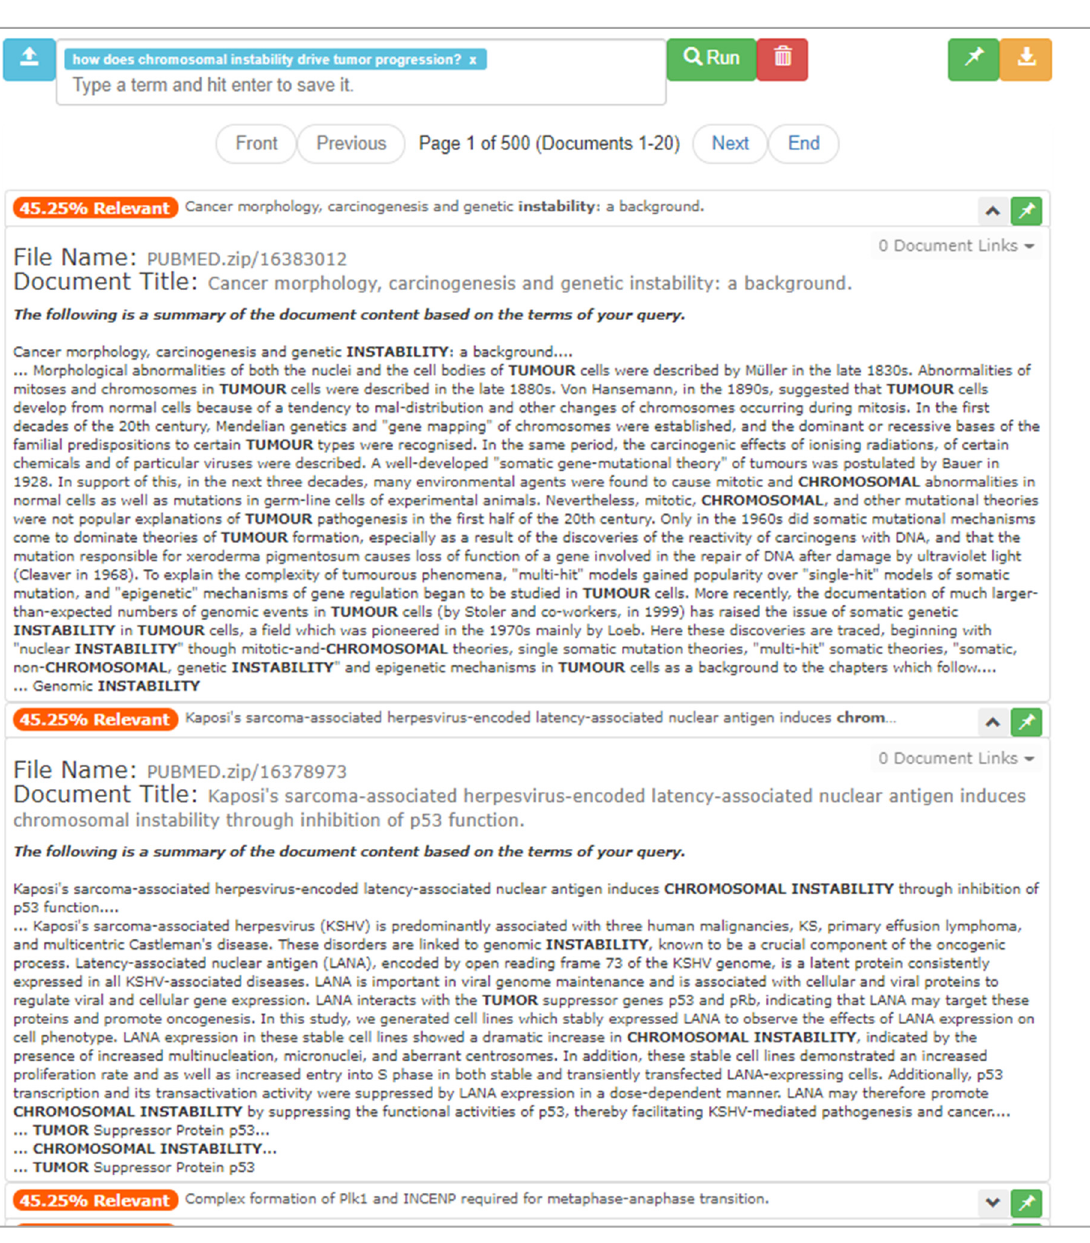
Figure 10. ONTSI after opening the documents “Cancer morphology, carcinogenesis and genetic instability: a background” and “Kaposi’s sarcoma–associated herpesvirus–encoded latency-associated nuclear antigen induces chromosomal instability through inhibition of p53 function.”